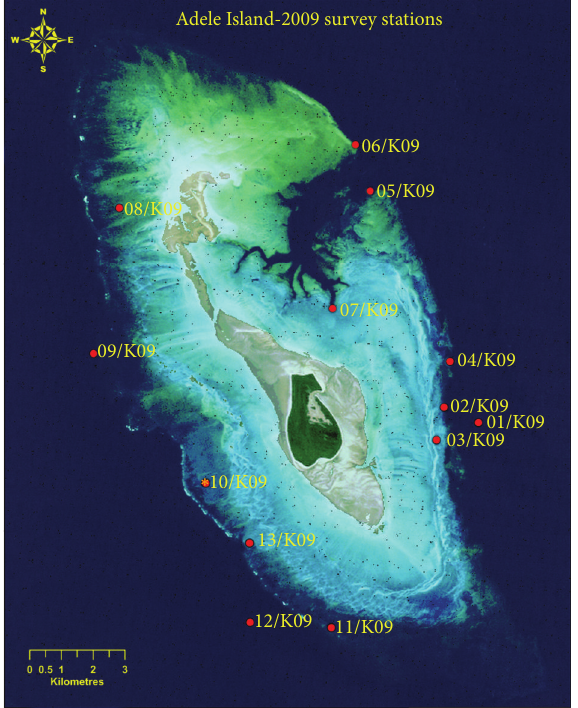
Figure 2: Satellite image of the extensive coral reef surrounding Adele Island with survey stations highlighted, the rollolith habitat zone is denoted by a